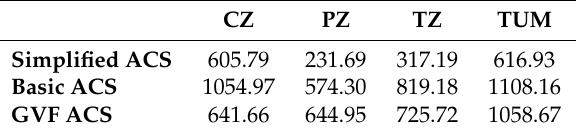
Table 2. Execution time (in ms) for each segmentation algorithm, and for each prostate